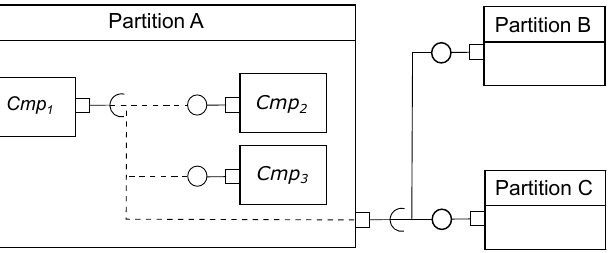
Figure 16. Sampling data produced by a software component sent to multiple destinations. An enhanced connector is used inside Partition A to multicast